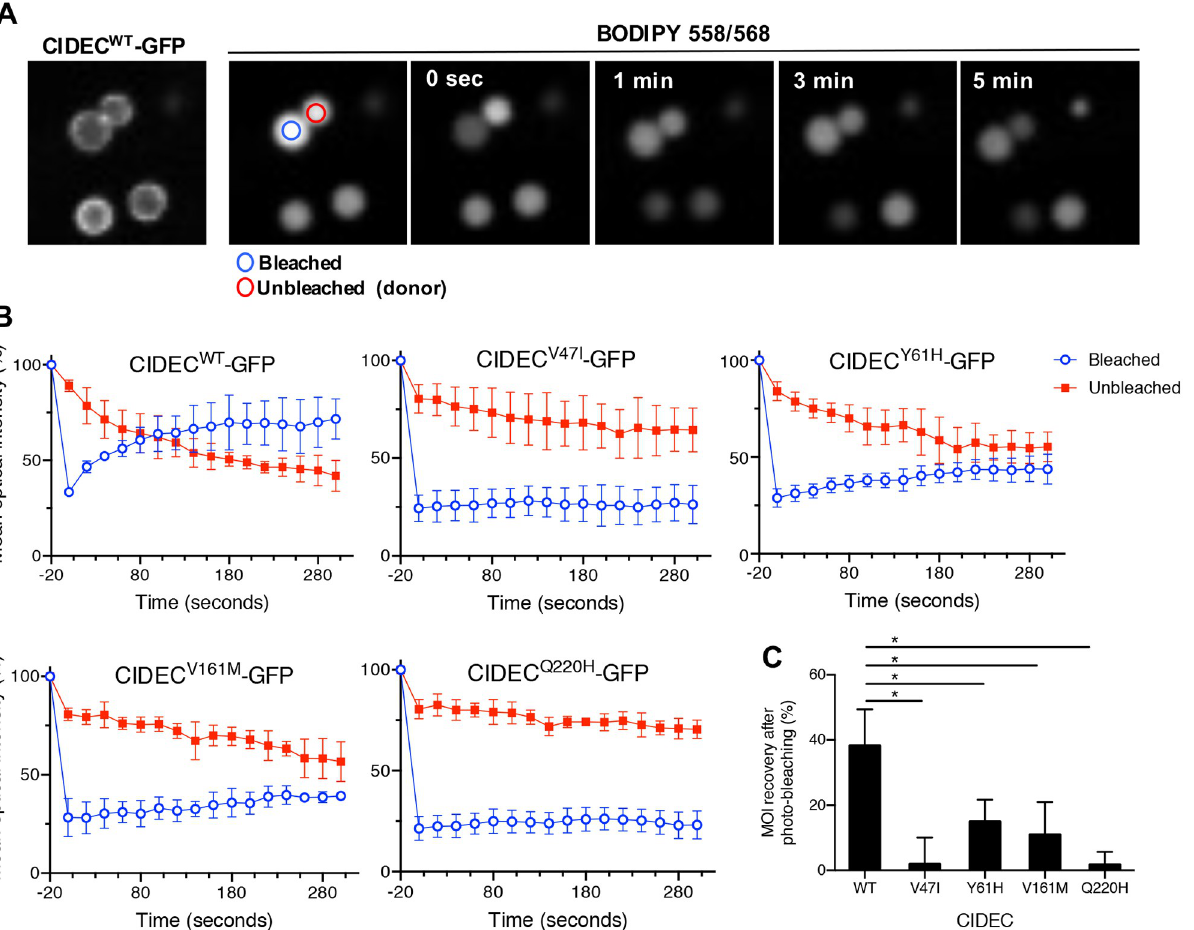
Fig 5. AMD CIDEC variants cause a decrease in the lipid exchange rate between lipid droplets (LDs). (A) Representative Fluorescence Recovery After Photobleach (FRAP) images of paired LD expressing GFP-tagged CIDEC wild-type (WT) showing progressive neutral lipid (BODIPY 558/568 dye labeling) exchange as determined by fluorescence recovery from the adjacent LD. (B) Quantification of mean optical intensity (MOI) in the bleached (blue circle) and unbleached (red circle) LD in cells expressing CIDEC WT or each of the rare variants. (C) Percentage of MOI recovery on bleached LDs from 0 sec. to 300 seconds. N = 3 (mean ± SD, Student’s t test, * p <